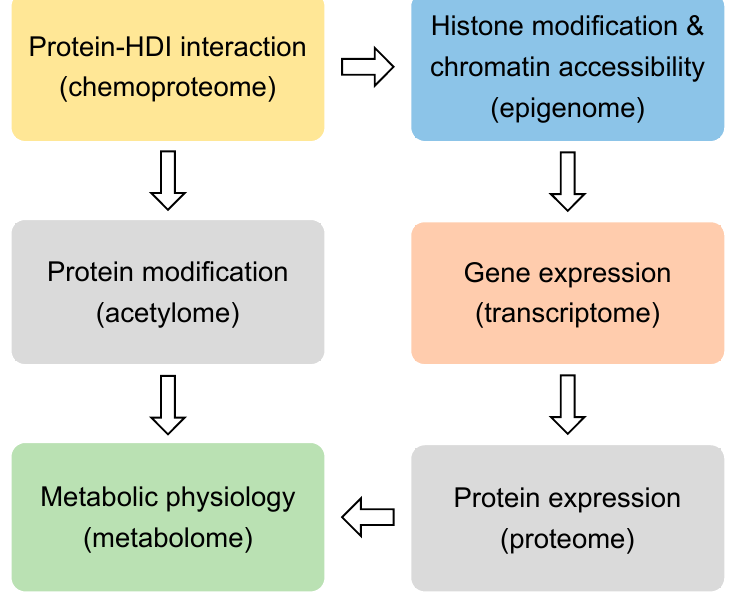
Figure 1. The omics approaches discussed in this review.